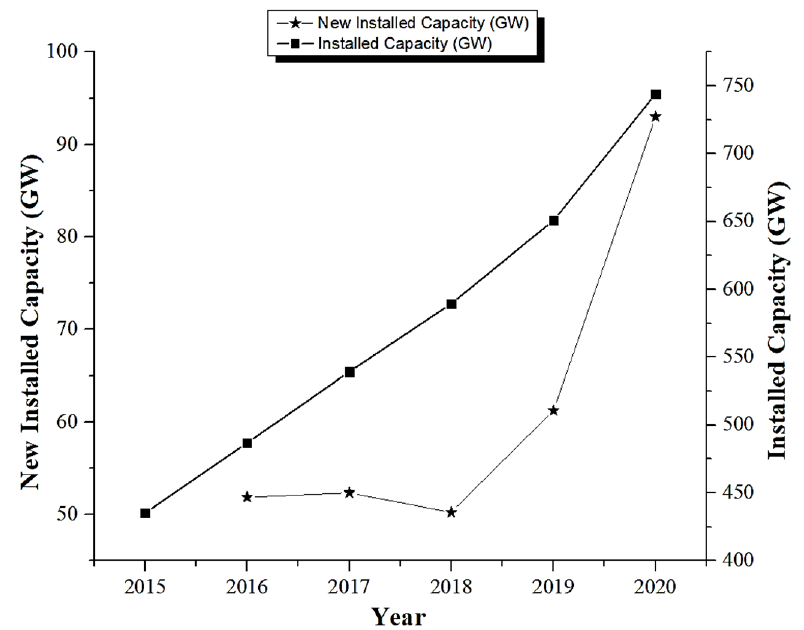
Figure 1 . Global capacity installation from 2015 to 2020 . Figure 1. Global capacity installation from 2015 to